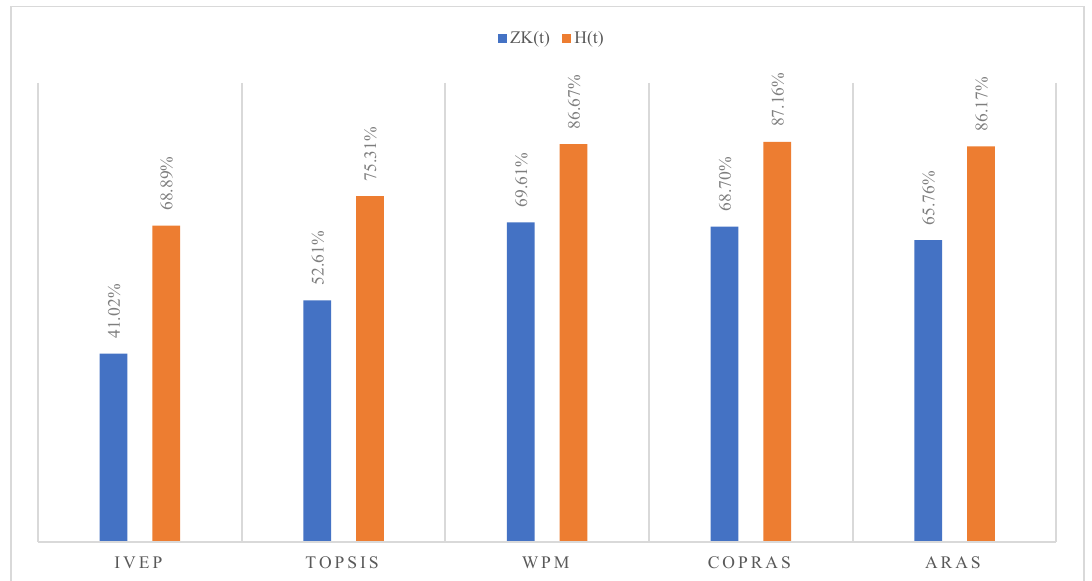
Figure 7. The comparison between similarities of IVPEP’s outputs with other algorithms’ outputs, generated by the Zakeri–Konstantas performance correlation coefficient (ZK) and the Hamming distance (HD).